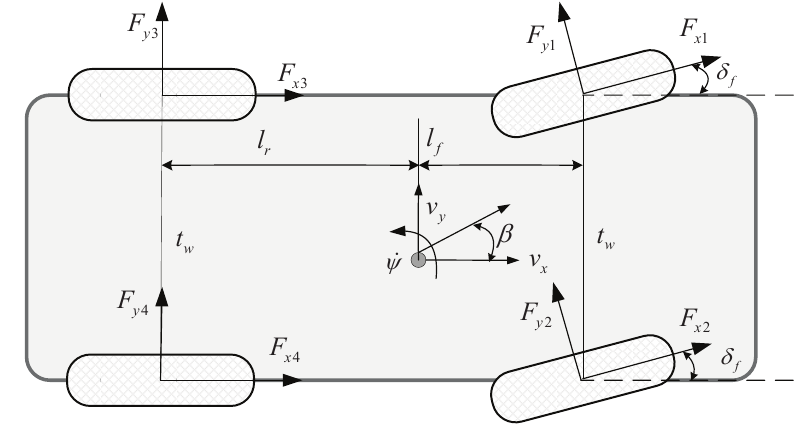
Figure 1. Two-track vehicle